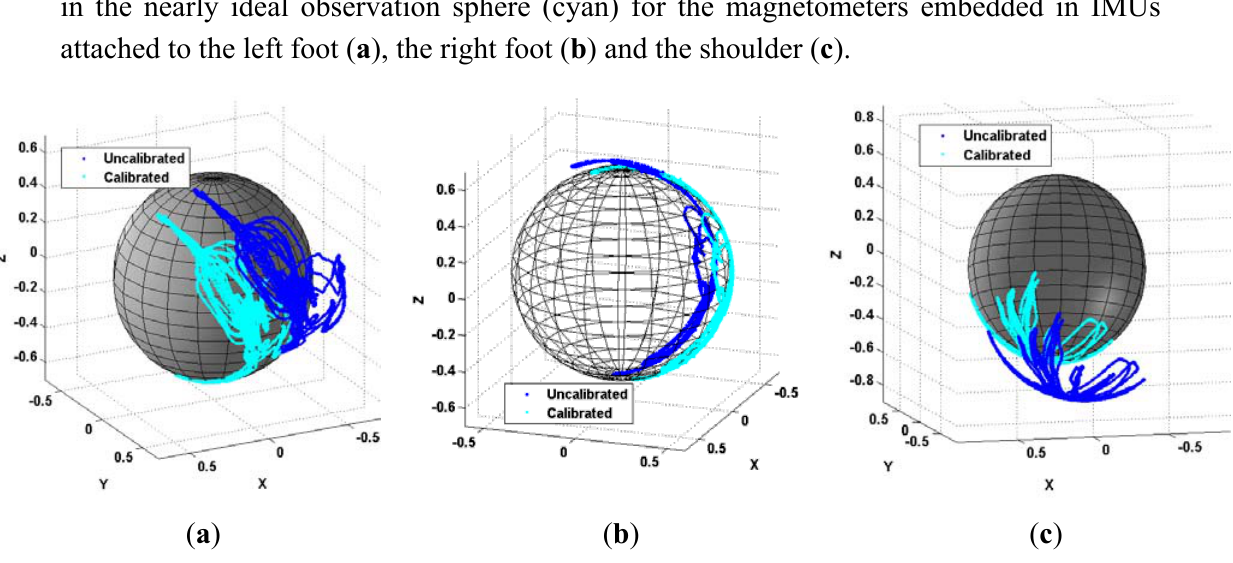
Figure 13. Norm, before (red) and after the calibration (green), of the magnetometer’s field measured with the IMUs attached to the left foot, the right foot and the shoulder. The norm of calibrated data equals the norm of the local Earth Magnetic Field: 0.57 Gauss for this dataset and